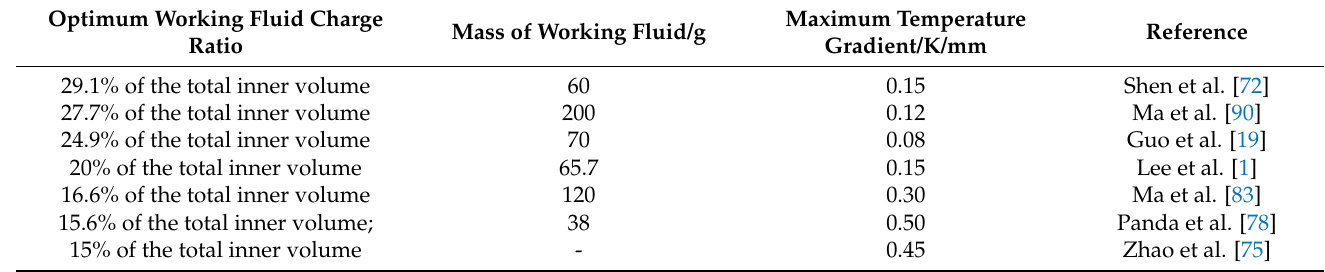
Table 8. Effect of the isothermal performance on working fluid charge ratio of heat